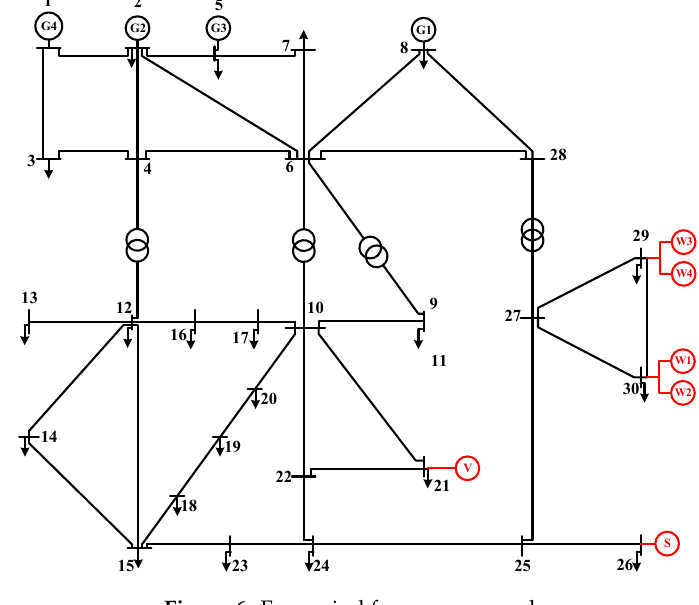
Figure 6. Four wind farm access mode.